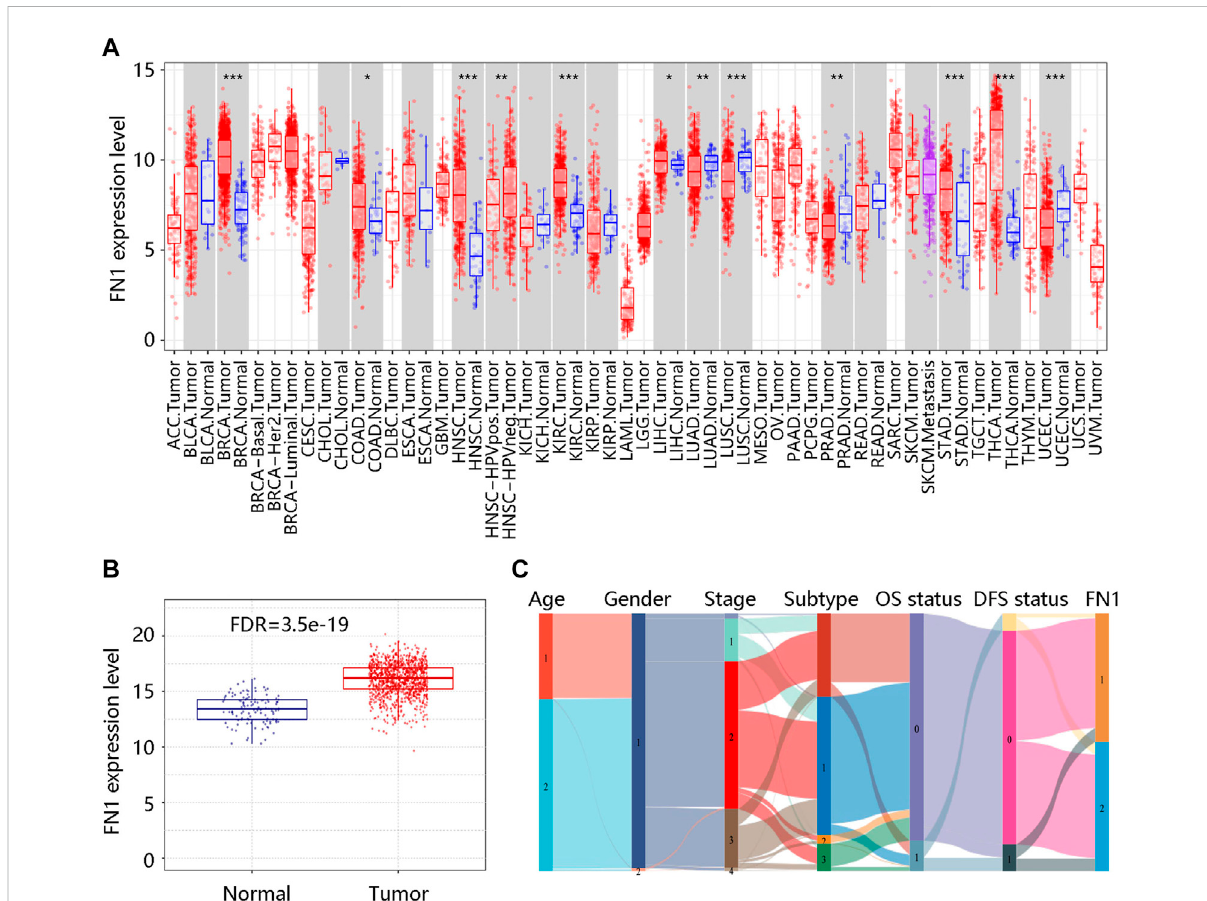
FIGURE 1 FN1 mRNA expressioninbreastcancer and other different types of human cancers. (A) Signi fi cantly different FN1 mRNA expression in12 tumor types intheTIMER database. * p < 0.05; ** p < 0.01; *** p < 0.001. (B) Signi fi cantly higher FN1 mRNAexpressioninbreastcancertissue comparedwith normal breast tissue in the GSCA database. FDR, false discovery rate. (C) The association of FN1 expression with different clinical characteristics by the Sankey diagram based on the TCGA BRCA data. Age: 1 represents ≤ 51 (years), 2 represents > 51 (years); Gender: 1 represents female, 2 represents male; Subtype: 1 represents luminal, 2 represents HER2+, 3 represents triple-negative; OS status: 0 represents living; 1 represents deceased; DFS status: 0 represents disease-free; 1 represents recurred; FN1: 1 represents low FN1 mRNA expression, 2 represents high FN1 mRNA expression. OS, overall survival; DFS, disease-free